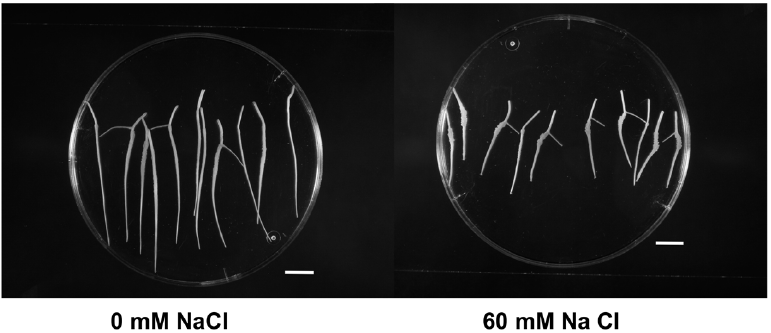
Figure 1. In vitro growth of Prunus excised roots of Masto de Montañana under different salt-stress conditions. The apexes in the figure correspond to day 15 (scale bar 10 mm).